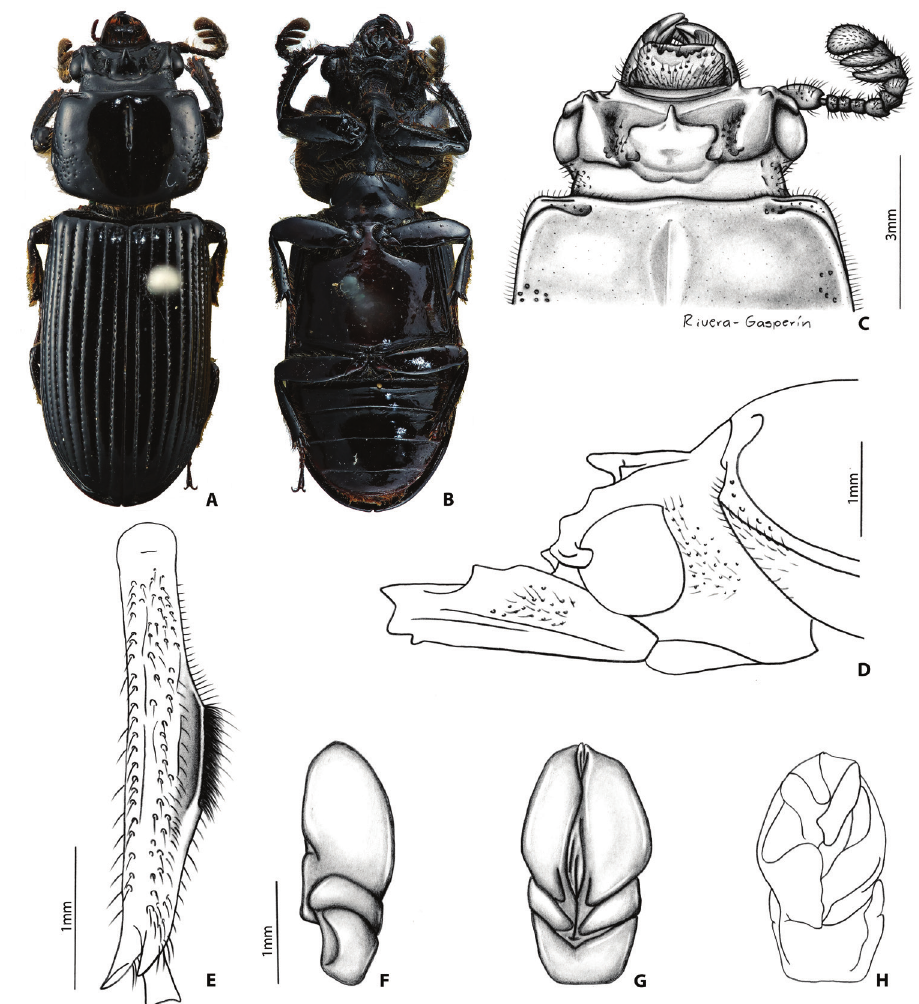
Figure 5. Yumtaax recticornis (Burmeister), lectotype: A dorsal habitus B ventral habitus C dorsal view of pronotum and head D lateral view of pronotum and head E lateral view of right mesotibia F lateral view of aedeagus G ventral view of aedeagus H dorsal view of aedeagus.